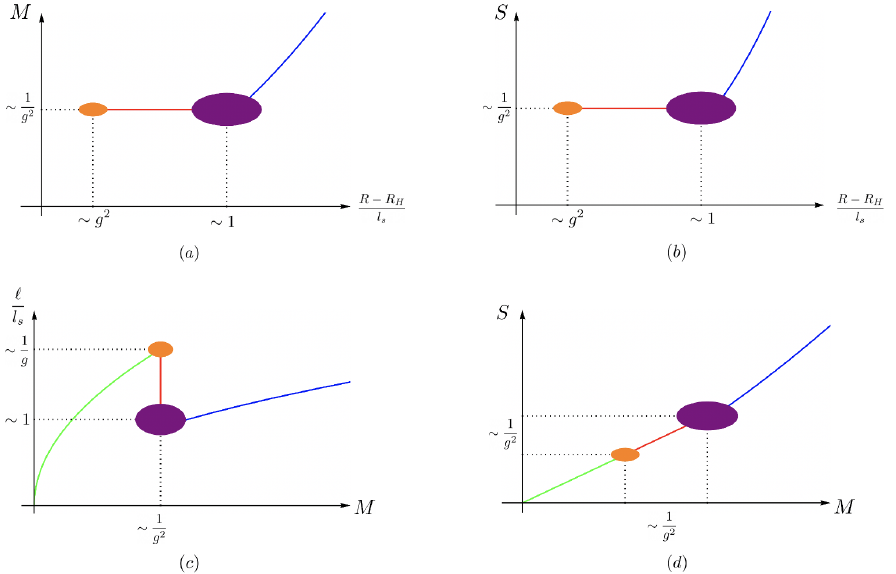
Figure 5 . The phase diagrams for d = 4 . In the plots, the blue, red, green lines represent the black hole, Horowitz-Polchinski solution and free strings, respectively. The orange and purple blobs denote the transition regions between the